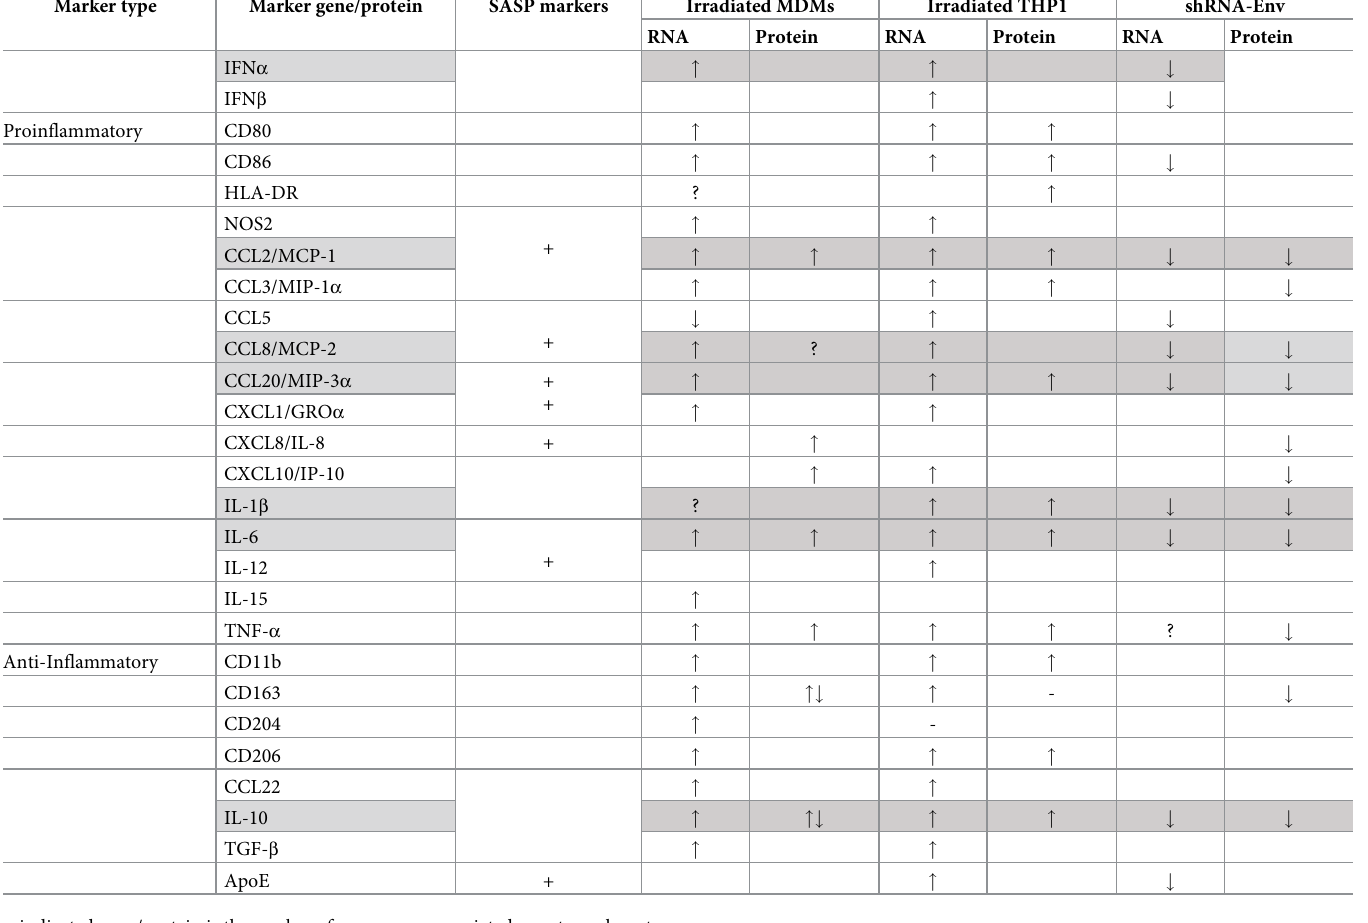
+ indicated gene/protein is the marker of senescence-associated secretory phenotype. " and # increased and decreased gene expression or secretion of protein, respectively. ? gene expression changed in different directions in biological replicates of the same experiment. Genes displayed stable HERV-related upregulation of expression are